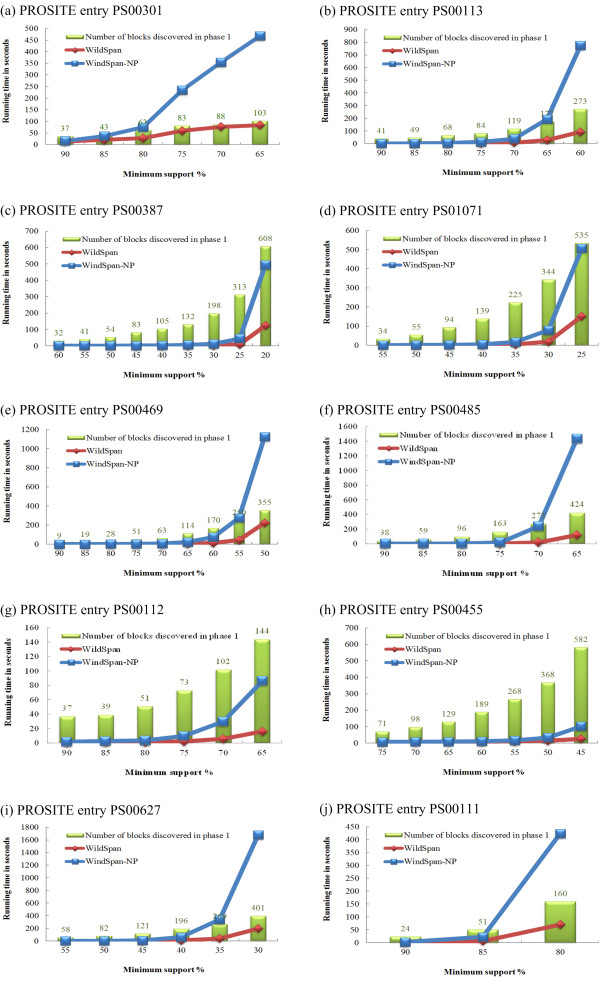
Performance comparison. This figure shows the running time of WildSpan versus WildSpan with no pruning (WildSpan-NP) on the PA10F dataset.